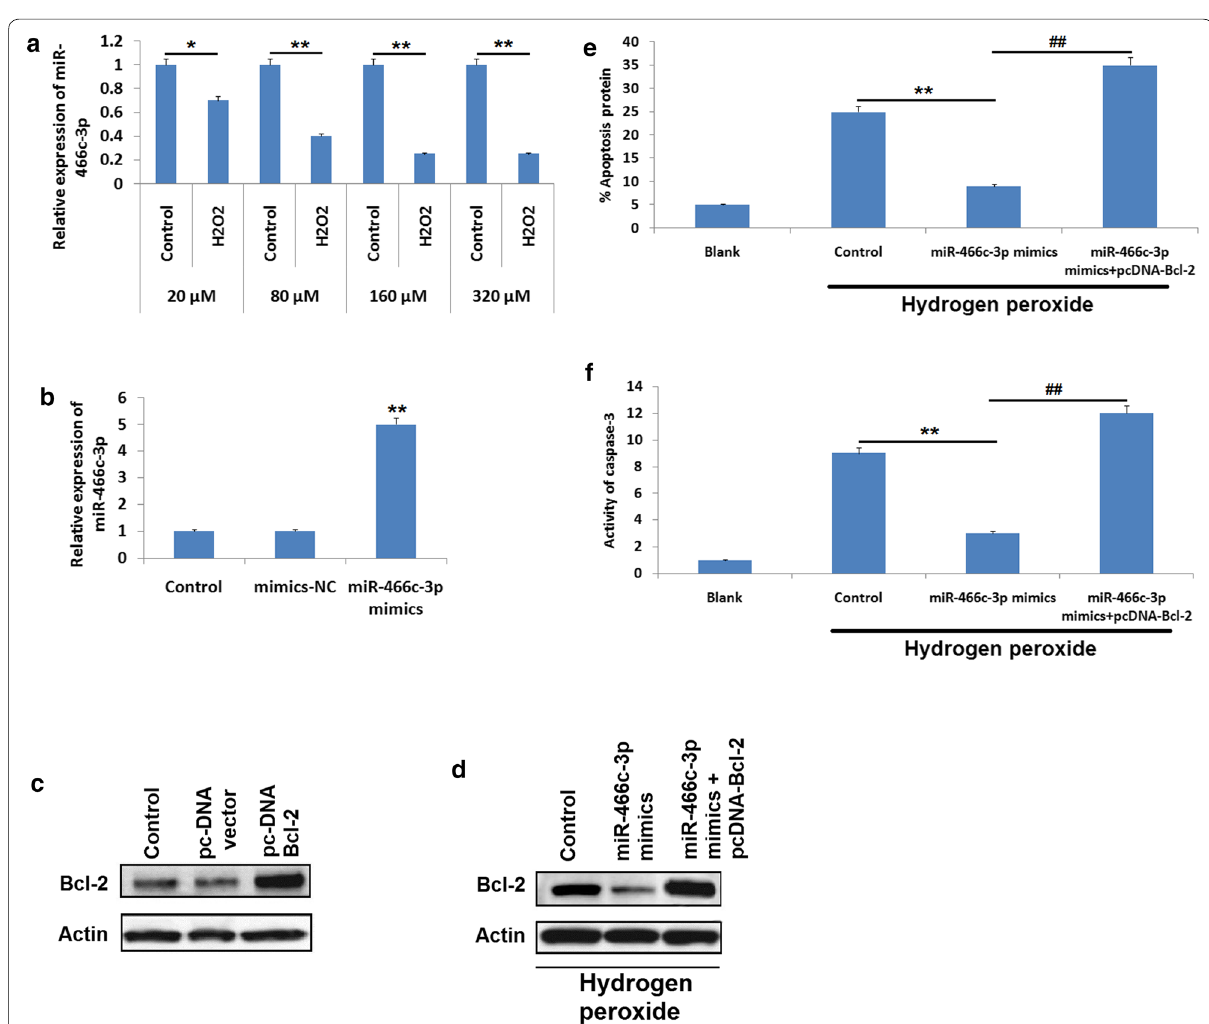
Fig. 4 a The N9 microglia cells were treated with hydrogen peroxide of varied concnetrions for 10 h followed by measuring the expression by qRT-PCR. *P < 0.05, **P < 0.01 compared to control. b qRT-PCR analysis for expression of miR-466c-3p in N9 microglia cells transfected with miR-466c-3p mimics or negative control.*P < 0.05, **P < 0.01 compared to mimice neative control group cells. c The N9 cells received transfection of pc-DNA-Bcl-2 or pc-DNA-vector followed by evaluation of Bcl-2 by western blot analysis. d The N9 cells were transfected with miR-466c-3p mimics or miR-466c-3p mimics along with pc-DNA-Bax and expression of Bcl-2 were estimated by western blot analysis. The cells were treated with hydrogen peroxide followed by transfection with miR-466c-3p mimics or miR-466c-3p mimics and pc-DNA-Bcl-2. e The number of cells under gone apoptosis and f activity of caspase-3 were evaluated with the help of flow cytometry and colorimetric analysis respectively. **P < 0.01, ##P < 0.01 compared to control and mimics